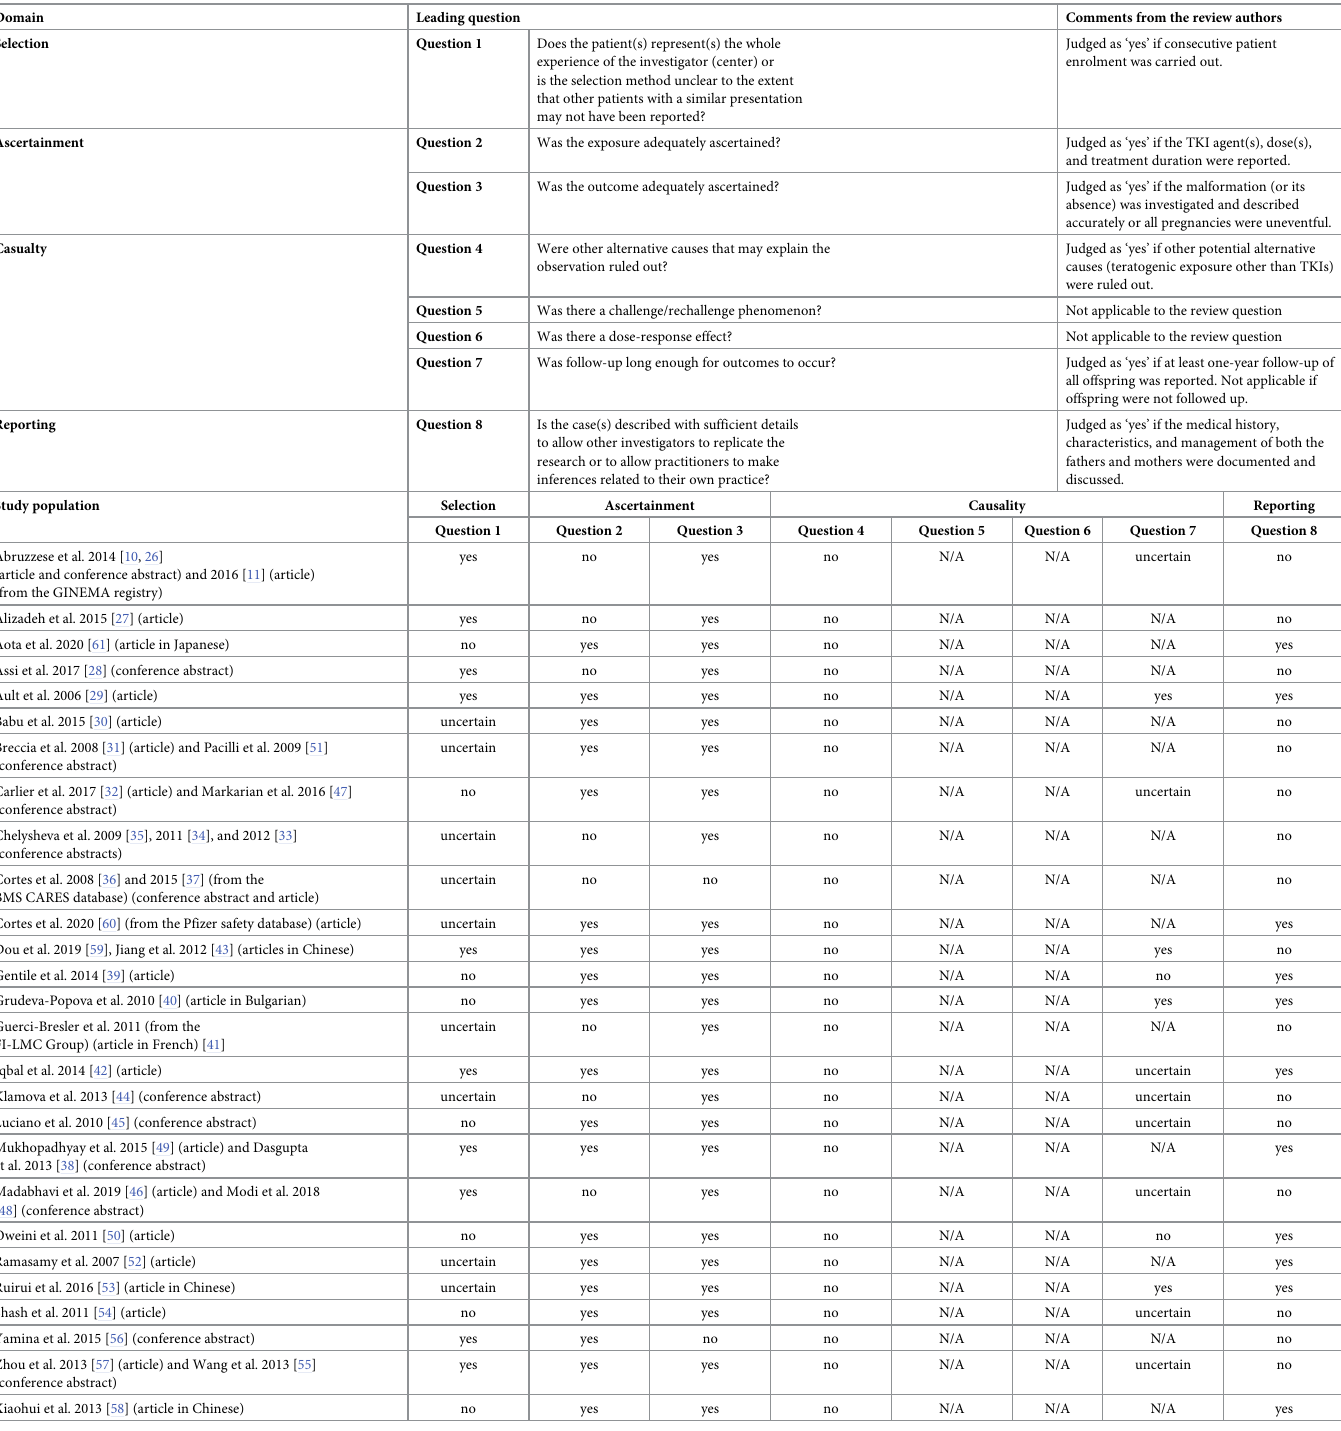
Table 4. Quality